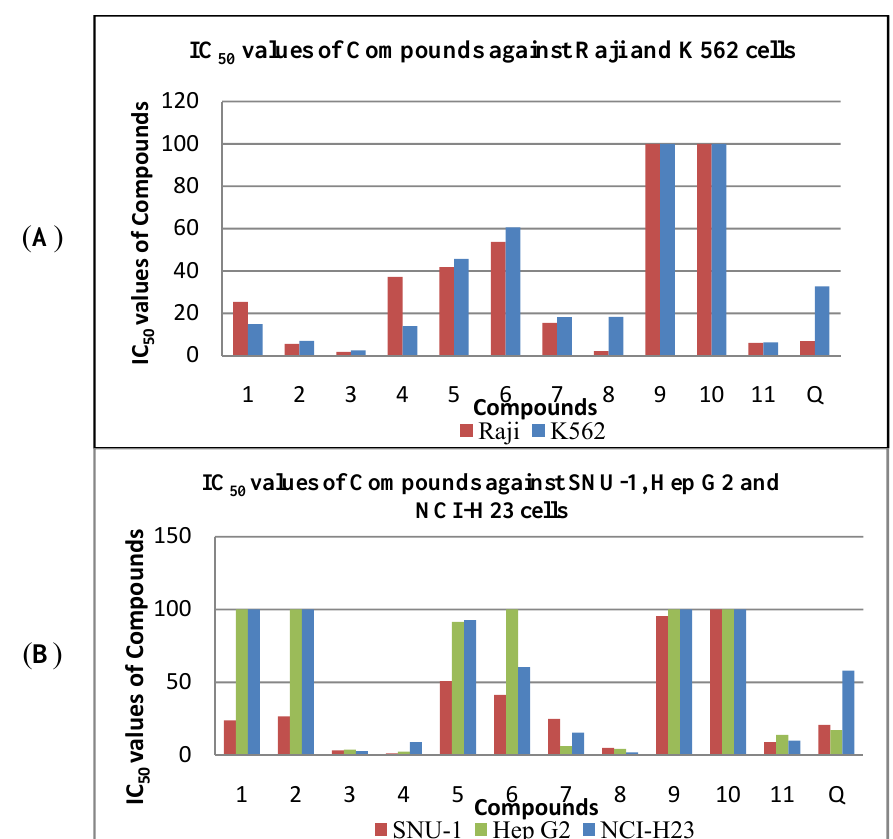
Figure 2. IC values of Compounds 1 – 11 and quercetin against ( A ) Raji and K562 cells, 50 ( B ) SNU-1, Hep G2 and NCI-H23 cells, ( C ) LS-174T, SK-MEL-28 and IMR-32 cells and ( D ) HeLa